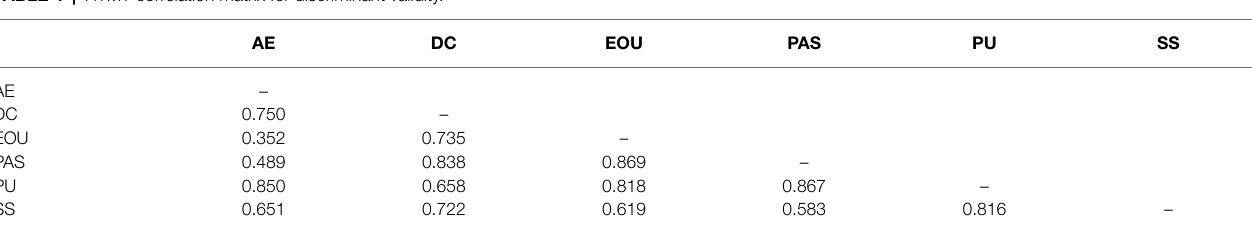
TABLE 4 | HTMT correlation matrix for discriminant